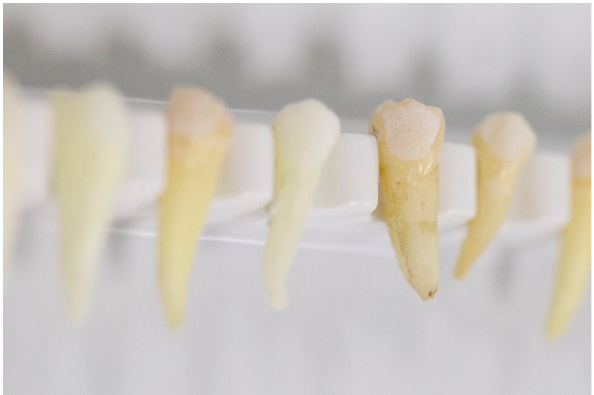
Figure 3. Rinsed and dried premolars.